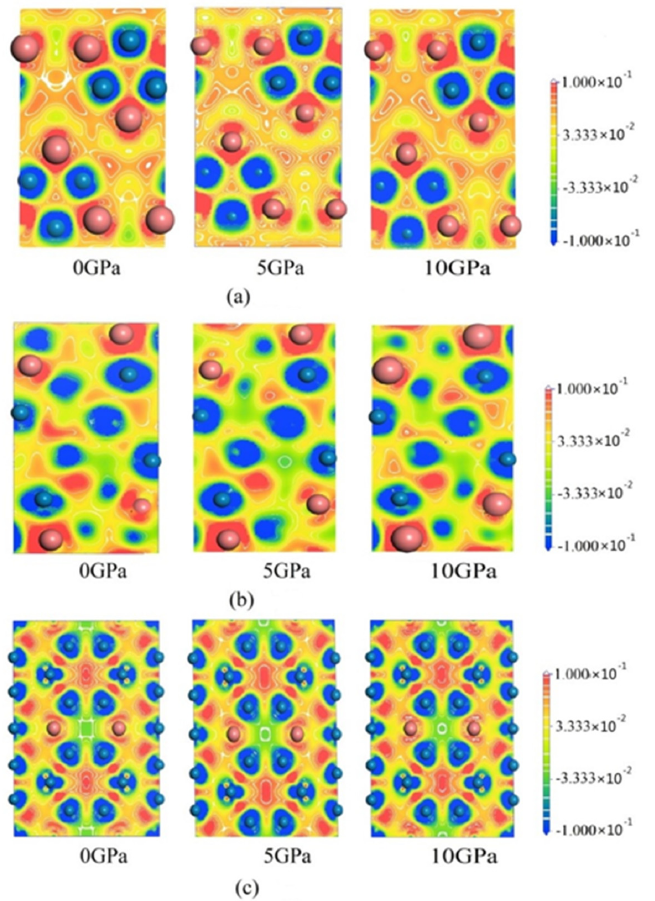
Figure 8. The charge density difference of ( a ) Cr 7 C 3 , ( b ) Cr 3 C 2 and ( c ) Cr 23 C 6 under different applied pressures.